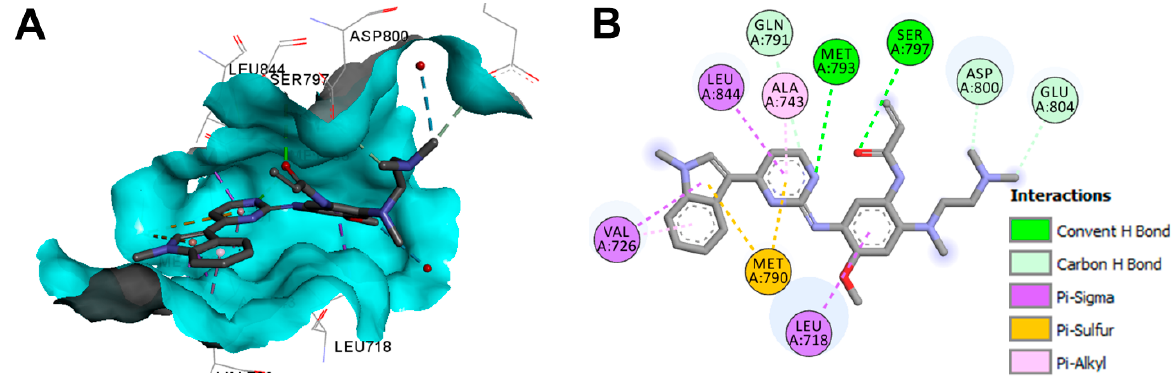
Figure 55. Binding modes of osimertinib (shown as sticks) into EGFR L858R/T790M/C797S (pdb: 6LUD): ( A ) 3D binding mode, receptor shown as hydrogen bond surface; ( B ) 2D binding mode showing different types of binding interactions; the figure was generated using Discovery Studio Visualizer (V16.1.0.15350).